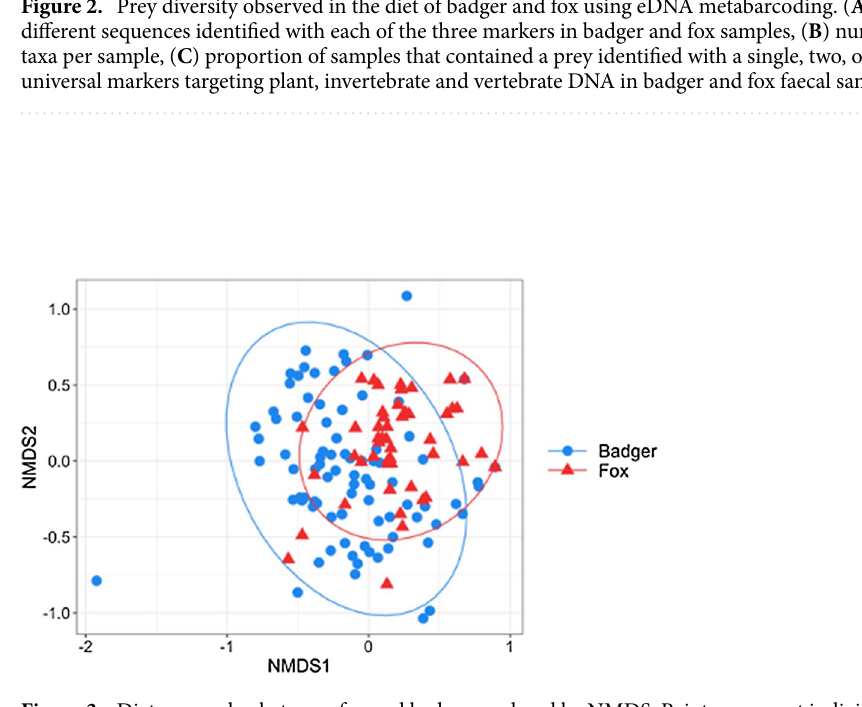
Figure 3. Dietary overlap between fox and badger, analysed by NMDS. Points represent individual samples with 95% confidence ellipses for badger (blue circles) and fox (red triangles). Using adonis, we identified significant dietary divergence between the two predators (df = 1, F = 8.82, p =